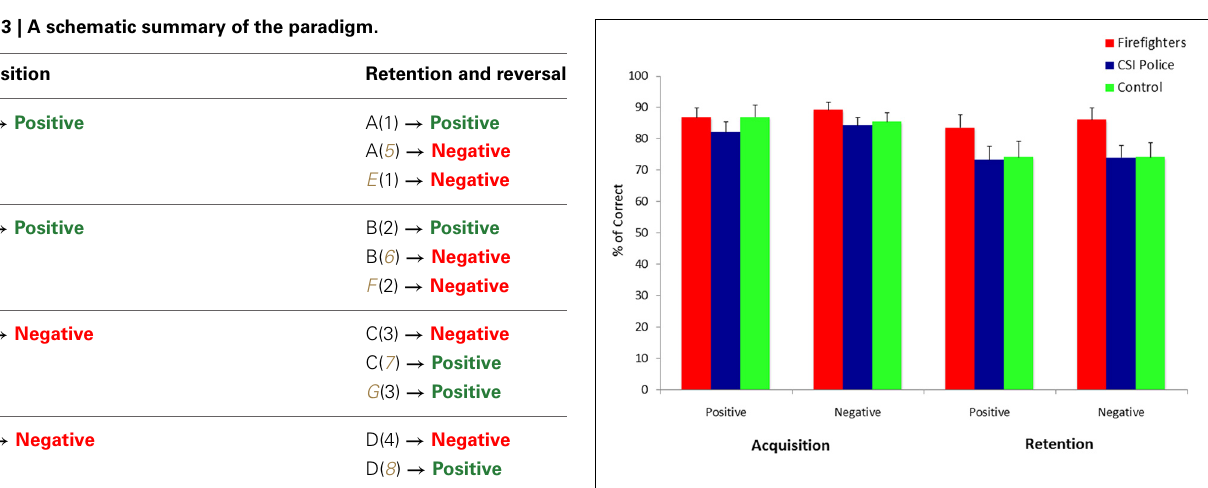
FIGURE 3 | Percentage of correct responses to the four original boxes as a function of Phase (acquisition vs. retention), Outcome (positive vs. negative) and Experimental Group (trauma exposed firefighters vs. trauma exposed CSI police vs. trauma-unexposed